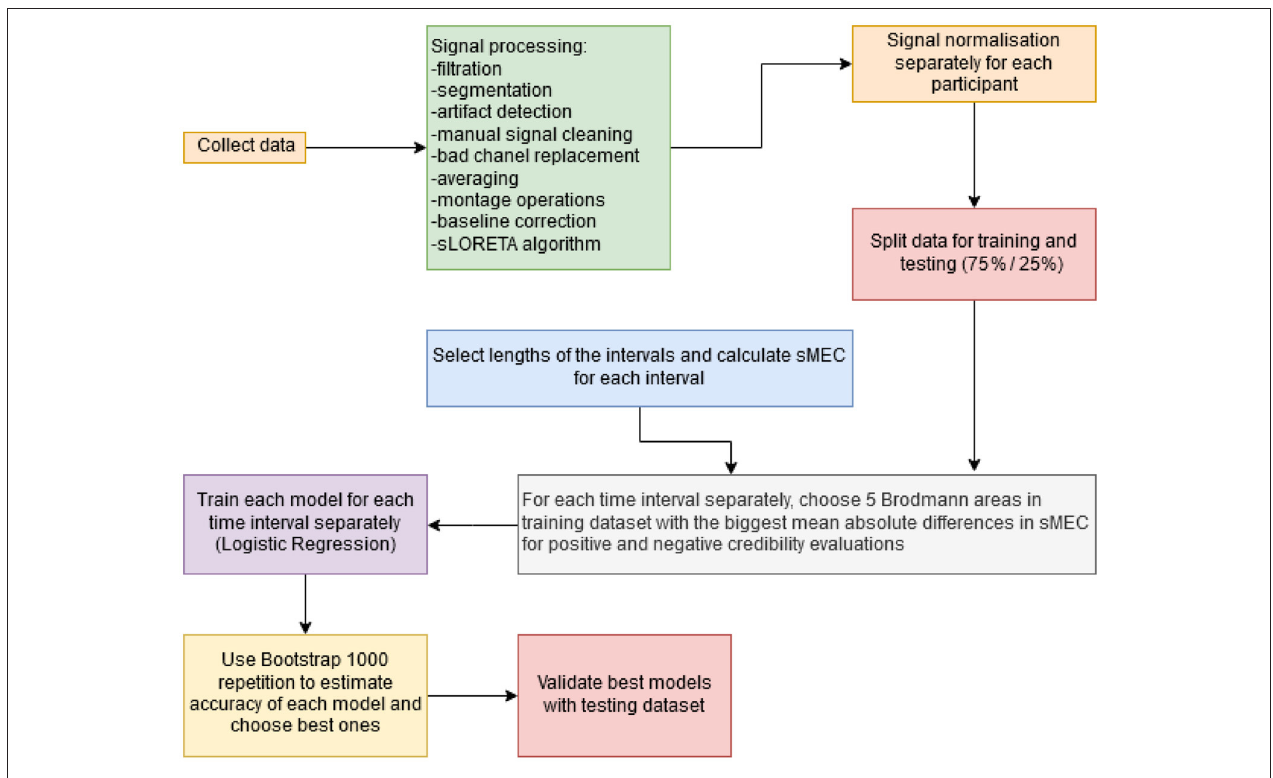
FIGURE 3 | Data processing steps in analysis of experimental